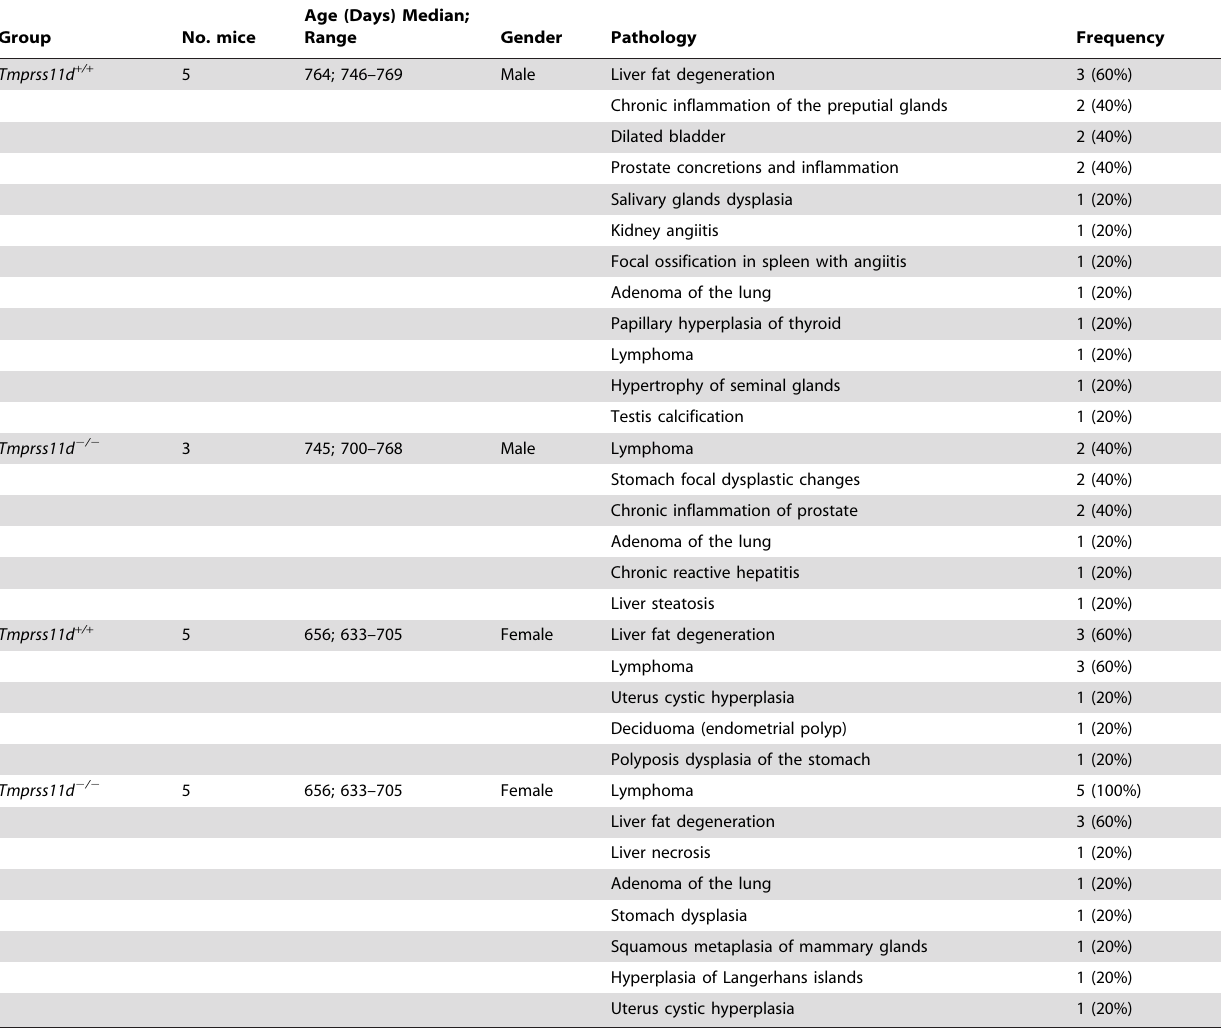
Table 4. Pathological findings in tissues from aging HAT-deficient mice.